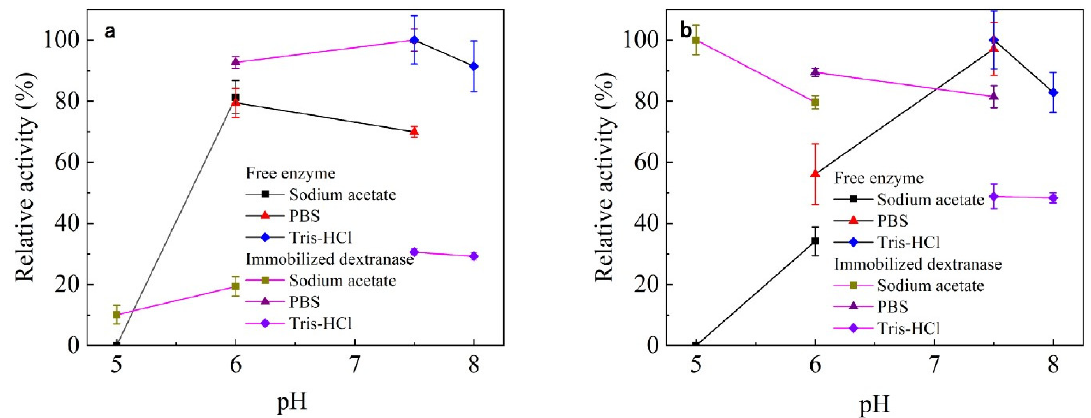
Figure 4. ( a ) Optimal pH, and ( b ) pH stability.